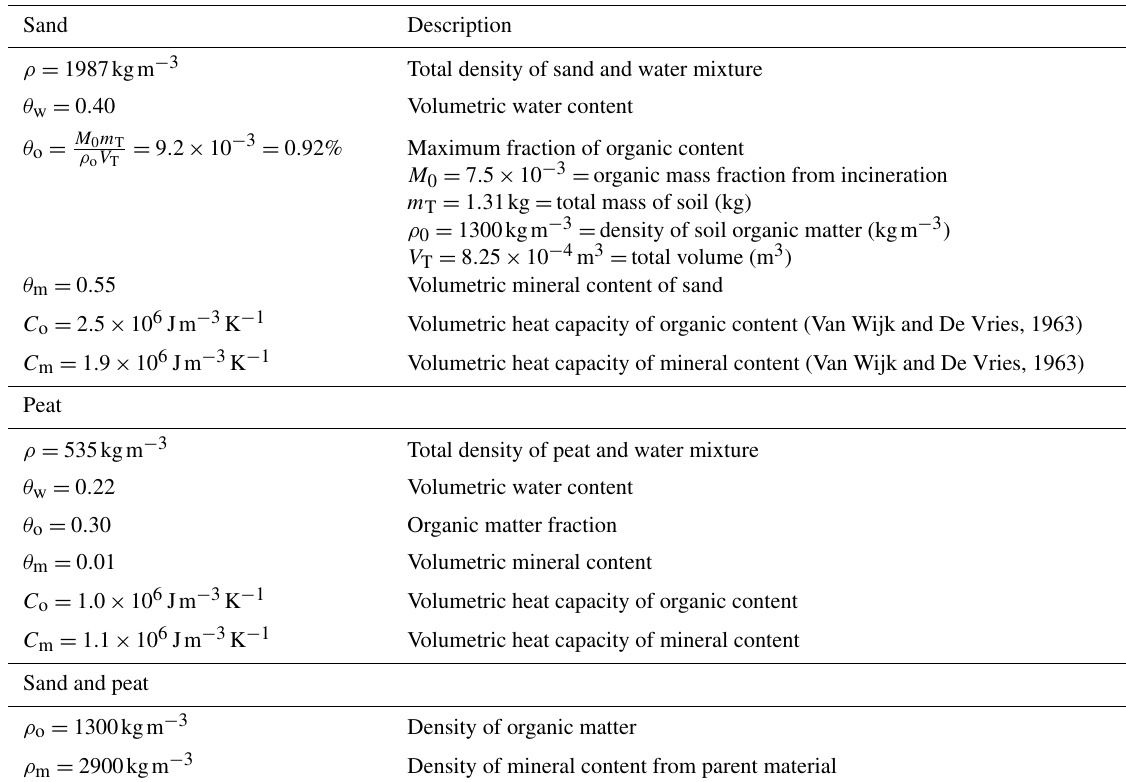
Table 1. Quantities utilized for sand and peat HPP